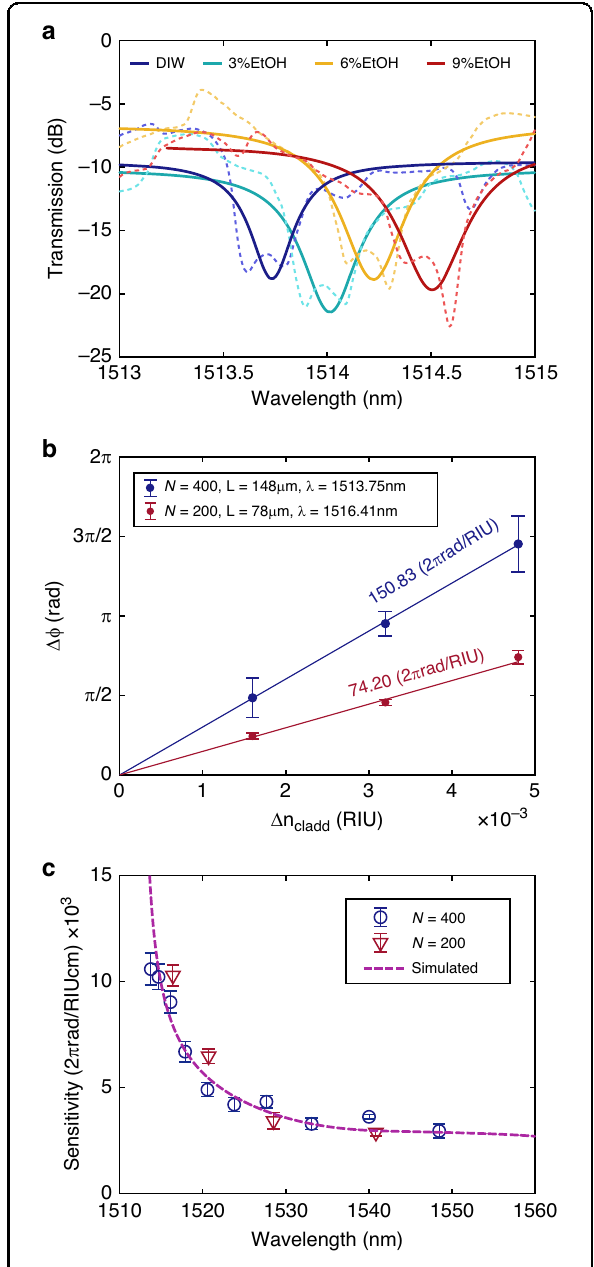
Fig. 6 Optical response for changes in the cladding refractive index. a Normalized experimental spectra obtained for the N = 400 con fi guration fabricated without a silica cover layer when the structure is covered with different ethanol concentrations in DIW dilutions. Raw data are depicted as dashed lines, while the Lorentzian fi tting over the fi ltered spectra, removing the Fabry-Perot contribution, is represented as solid lines. b Phase shift measurements for both the N = 200 and N = 400 con fi gurations as a function of the linear increments in the cladding RI. c RI sensitivity experimentally obtained for N = 200 and N = 400 bimodal 1D PhC sensors as the slope of the linear fi tting for different changes in the cladding RI. These values are scaled to a 1 cm length to compare our results with the literature. The pink dashed line represents the simulated sensitivity curve obtained from the theoretical band structures under similar